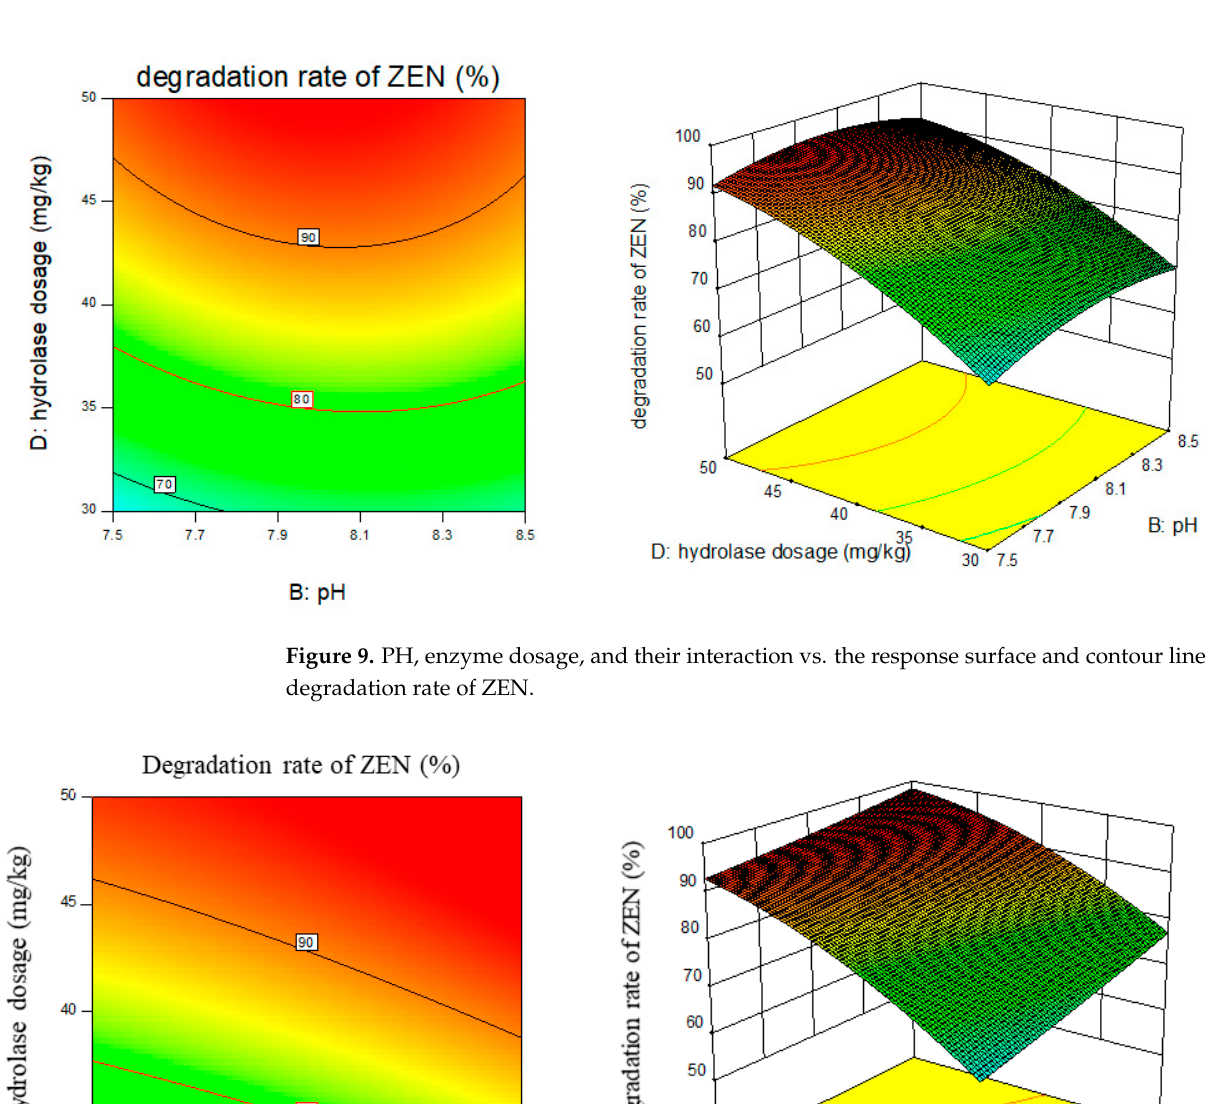
Figure 8. PH, time, and their interaction vs. the response surface and contour line of the degradation rate of ZEN.